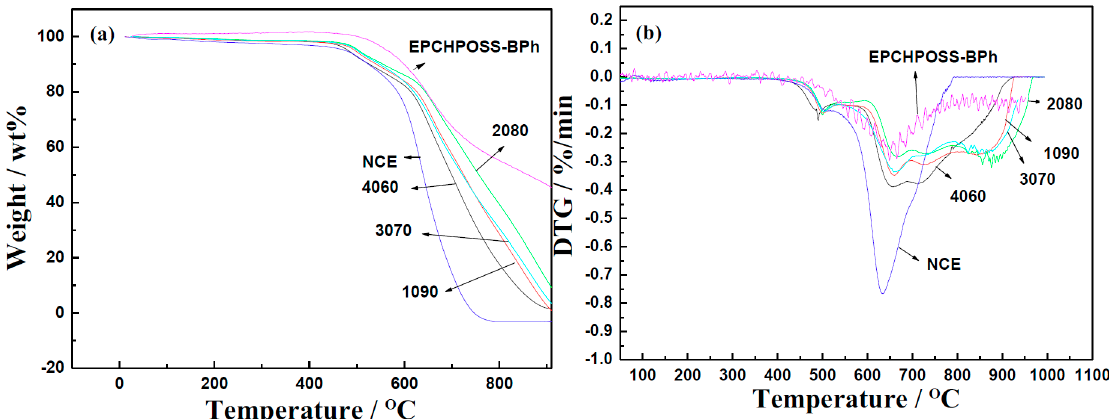
Figure 8. Thermogravimetric analysis (TGA) and Derivative (DTG) plots of NCE, EPCHPOSS–BPh, 1090, 2080, 3070, and 4060 polymers in the air. ( a ) TG curves and ( b ) DTG curves. Table 1. Thermal stability of EPCHPOSS–BPh, 1090, 2080, 3070, 4060, and NCE polymers.